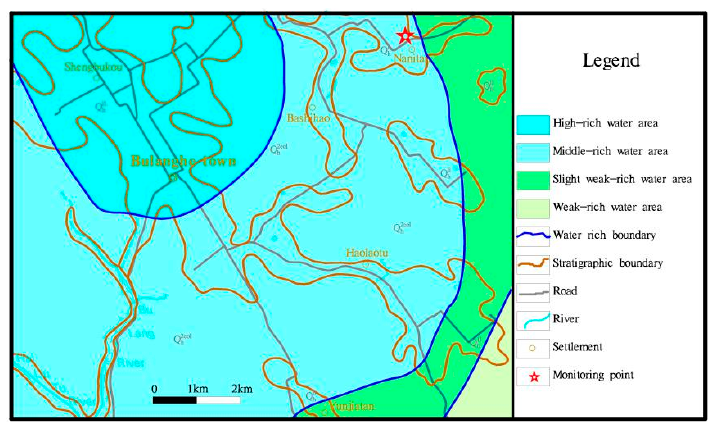
Figure 1. Location map of the field study.